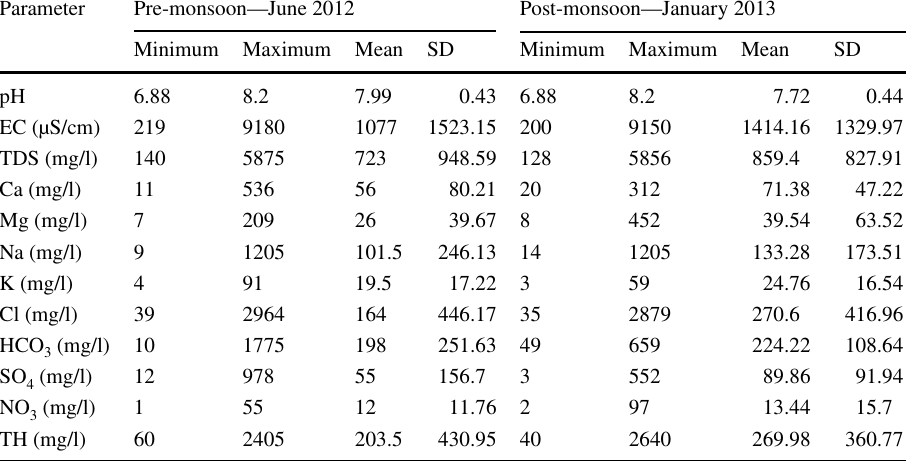
Table 1 Groundwater quality parameter statistics for various seasons